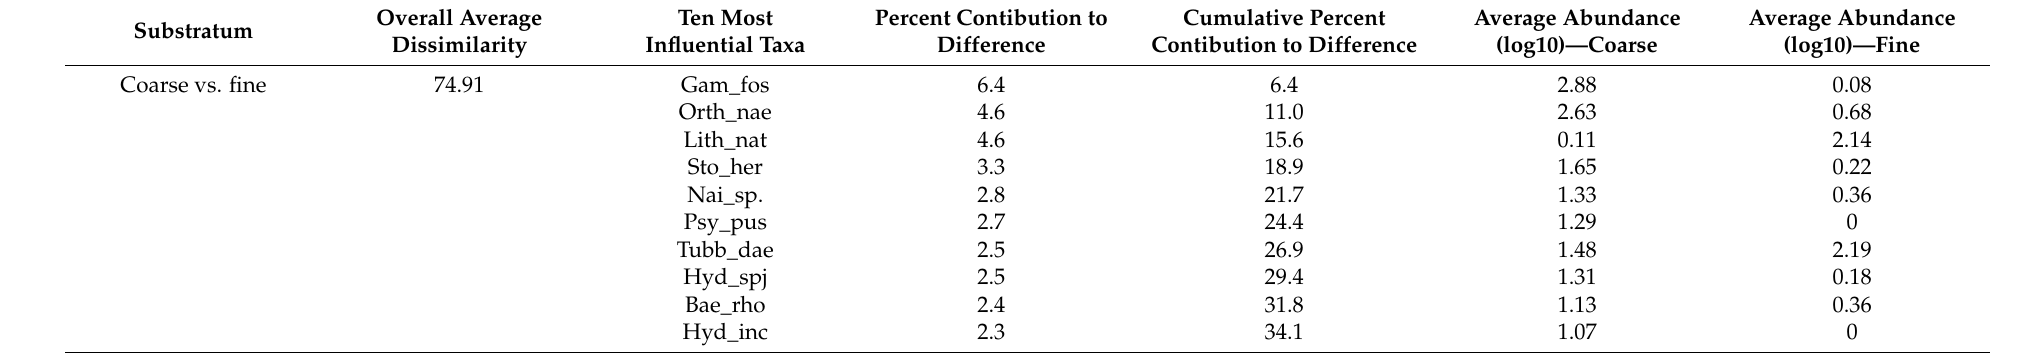
Ten Most Percent Contibution to Cumulative Percent Average Abundance Average Abundance Influential Taxa Difference Contibution to Difference (log10)—Coarse (log10)—Fine